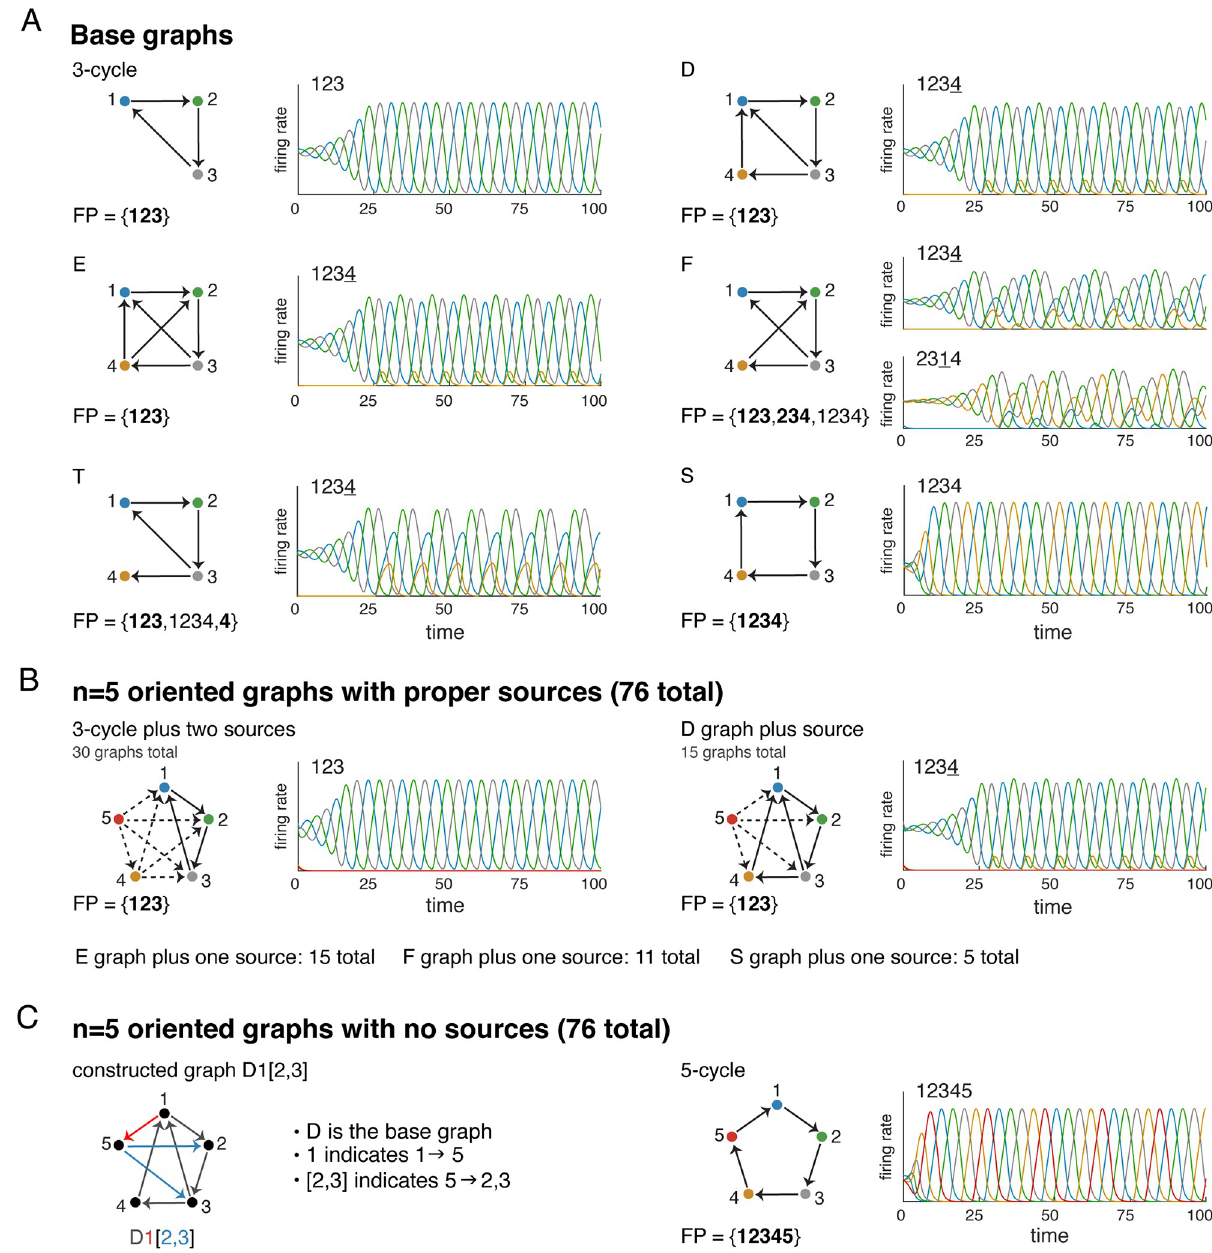
Fig 6. Taxonomy of n = 5 oriented graphs with no sinks. (A) Base graphs used to construct n = 5 graphs, and their corresponding attractors. Each attractor has a sequence, indicating the (periodic) order in which the neurons achieve their peak firing rates. (B) The oriented graphs with sources can be constructed by adding proper sources to each of the base graphs. This yields 30 graphs from the 3-cycle base (left), 15 graphs from the D graph base (right), and an additional 15, 11, and 5 graphs from the E, F and S graph bases. (C) All oriented graphs with no sources or sinks can be constructed from one of the D, E, F, T, and S base graphs. The graph label completely specifies the graph by naming the base and indicating the incoming and outgoing edges to the added node 5. (Left) For example, D1[2, 3] is the graph constructed from the D graph with added edges 1 ! 5 and 5 ! 2, 3. (Right) The only oriented n = 5 graph with no sources or sinks that cannot be constructed in this way is the 5-cycle.